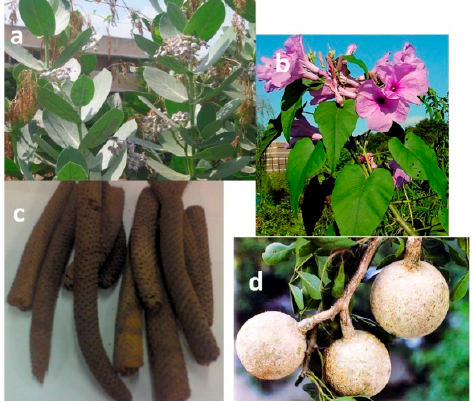
Figure 9. Wasteland weeds, ( a ) Calotropis gigantea , ( b ) Ipomoea carnea ; and agricultural wastes, ( c ) spikes of Borassus flabellifera and ( d ) shells from Limonea acidissima used for the production of microporous high surface area activated carbon materials